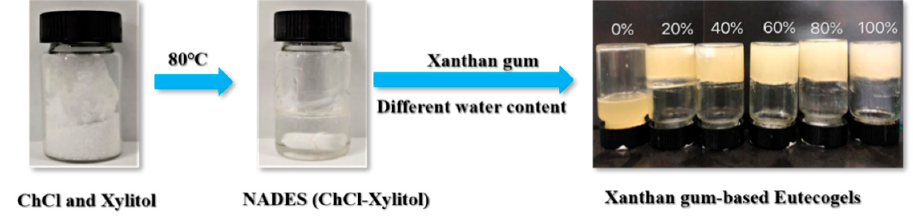
Figure 1. The preparation process of xanthan gum-based eutectogel.